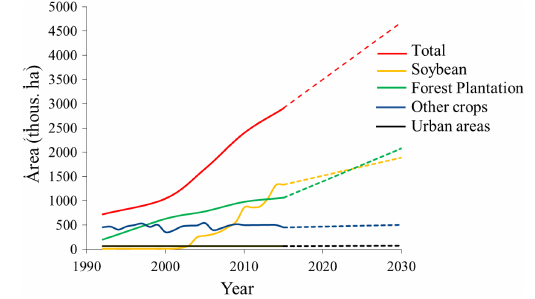
Fig. 3 . Dynamics of land transformation by soybean crop, other crops, exotic forest plantations, and urban areas in Uruguay between 1992 and 2015 (solid lines), rebuilt using different sources of official data (see text for details). Dashed lines indicate the projected land-use scenarios for